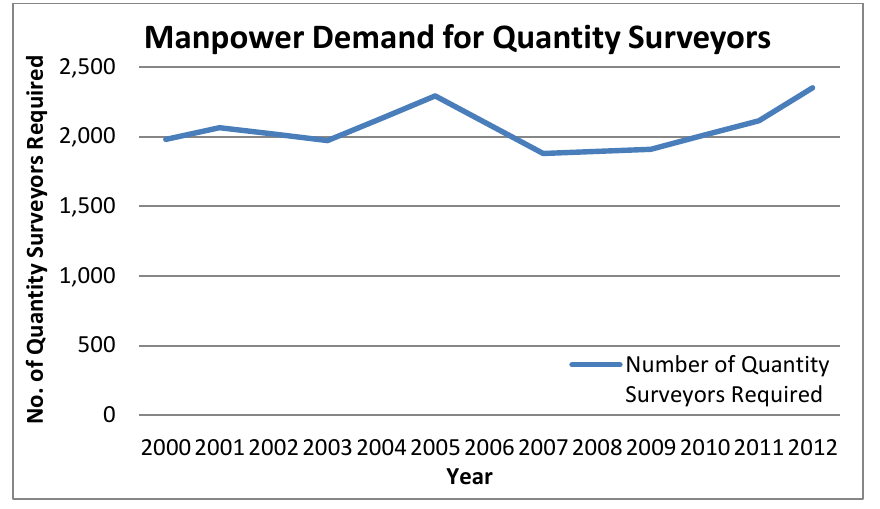
Figure 1 Manpower Demand for Quantity